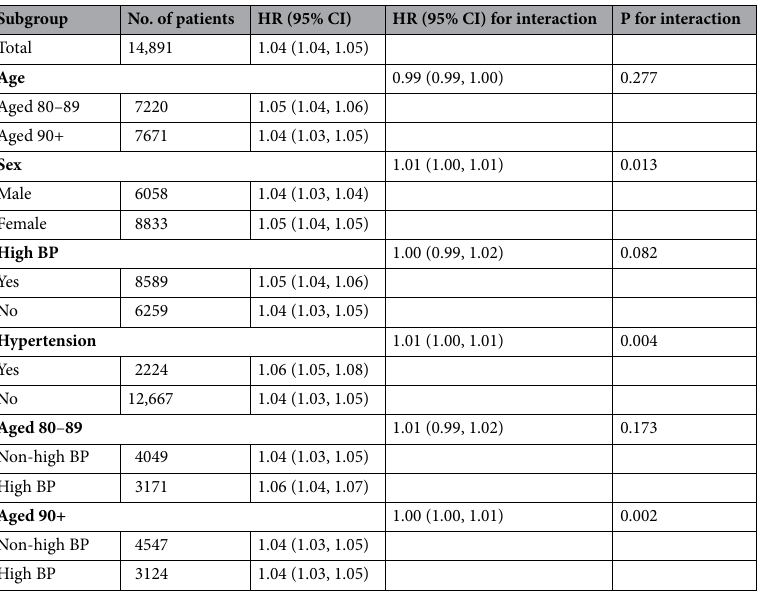
Table 2. Interaction effects on the association of cognitive decline, stratified as continuous categories, with mortality after adjustments for corresponding